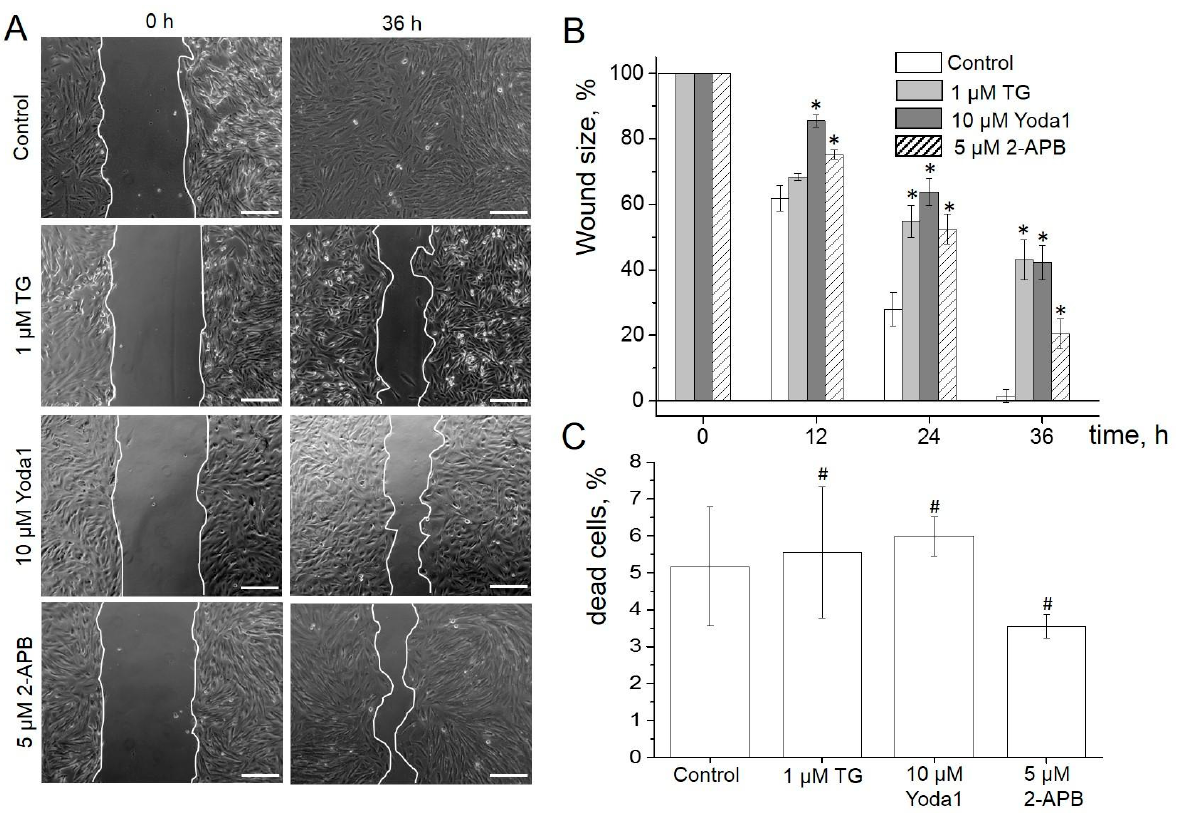
Figure 5. SOCE and Piezo1 in eMSCs migration. ( A ) Shown are representative images of the experimental wounds at the beginning (0 h) and the end of the wound healing assay (36 h). The scale bar is 200 µ m ( B ). The eMSC wound healing dynamics in the presence of TG, Yoda1 or 2-APB in the culture media. Wound sizes are shown as mean ± SEM ( n = 3–4 for each condition). * significantly different compared to control, Student’s t -test with Welch’s corrections, p < 0.05. ( C ) No significant changes in the viability of eMSCs were observed. Shown is the mean percent (± SD, n = 3) of dead cells for each experimental condition. #—not significantly different compared to control, two-sam- ple Student’s t -test ( p < 0.05).